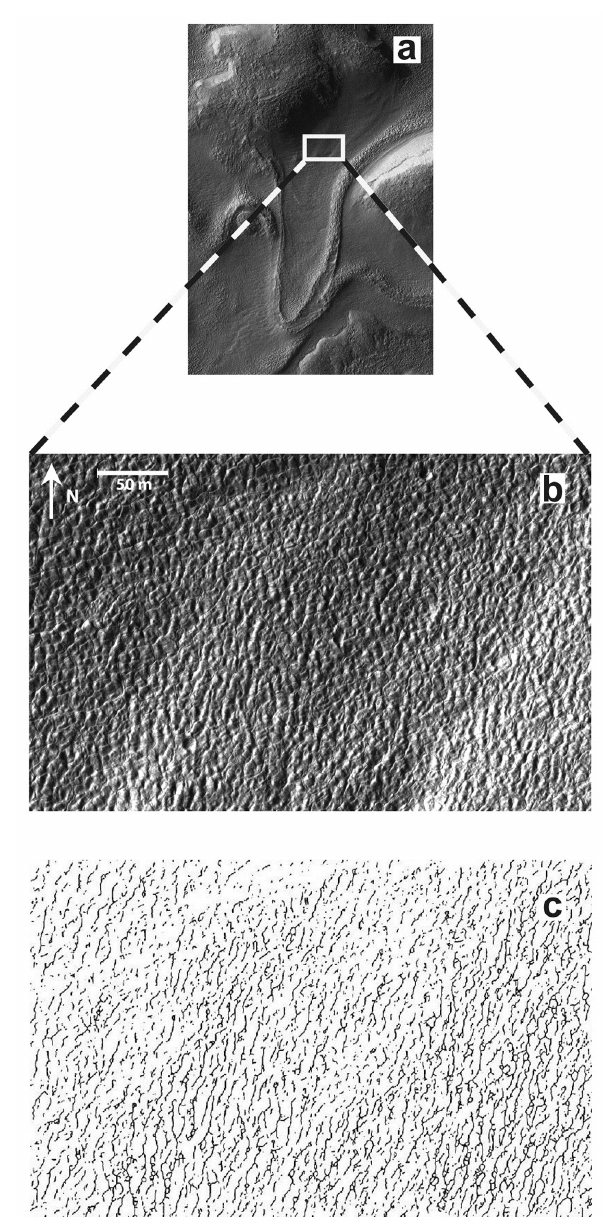
Figure 10. Surface incisions on GLF #947 imaged by HiRISE to supplement those reported on GLF #948 by Hubbard et al. (2011). GLF #947 (a) with an expansion of the incised terrain (b) and trace of incised segments (c)